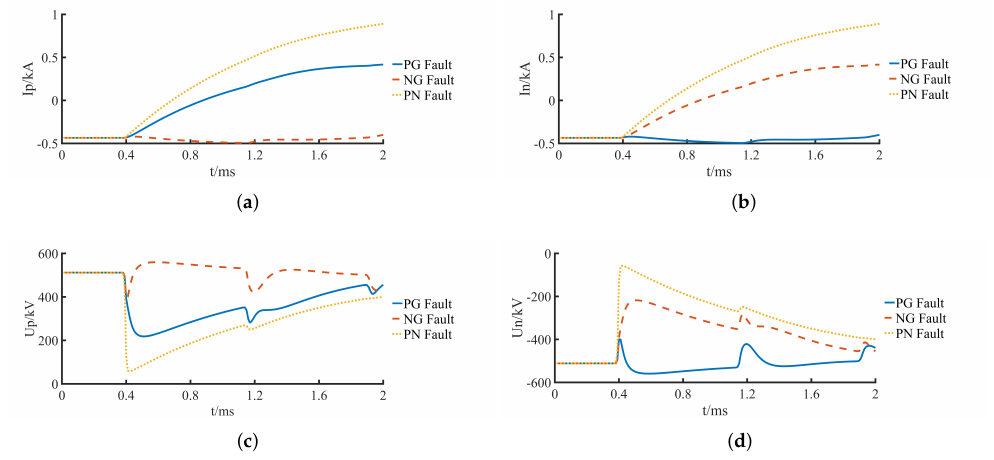
Figure 4. The waveforms under different fault of the 50% Line MN. ( a ) The fault waveforms of Ip; ( b ) The fault waveforms of In; ( c ) The fault waveforms of Up; ( d ) The fault waveforms of Un. The PG fault waveforms of the Line MN at different locations are shown in Figure 5.